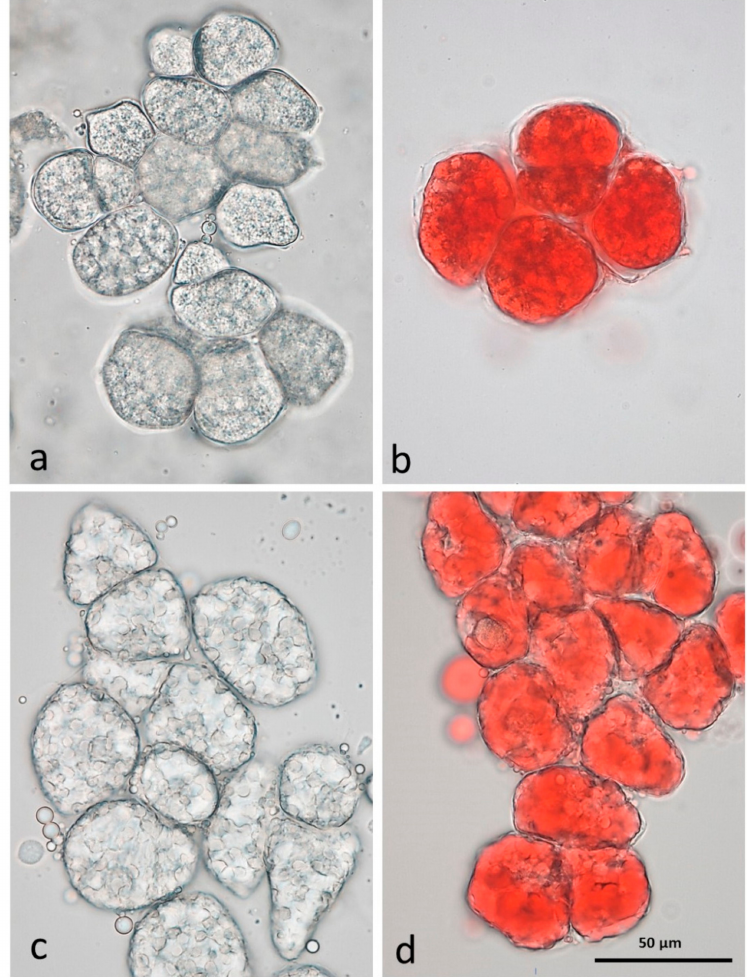
Figure 2. CDTA-separated cells of baseline natural raw almonds ( a ) unstained ( b ) lipid stained with Sudan IV and roasted almonds ( c ) unstained ( d ) lipid stained with Sudan IV showing lipid coalescence in the cells following